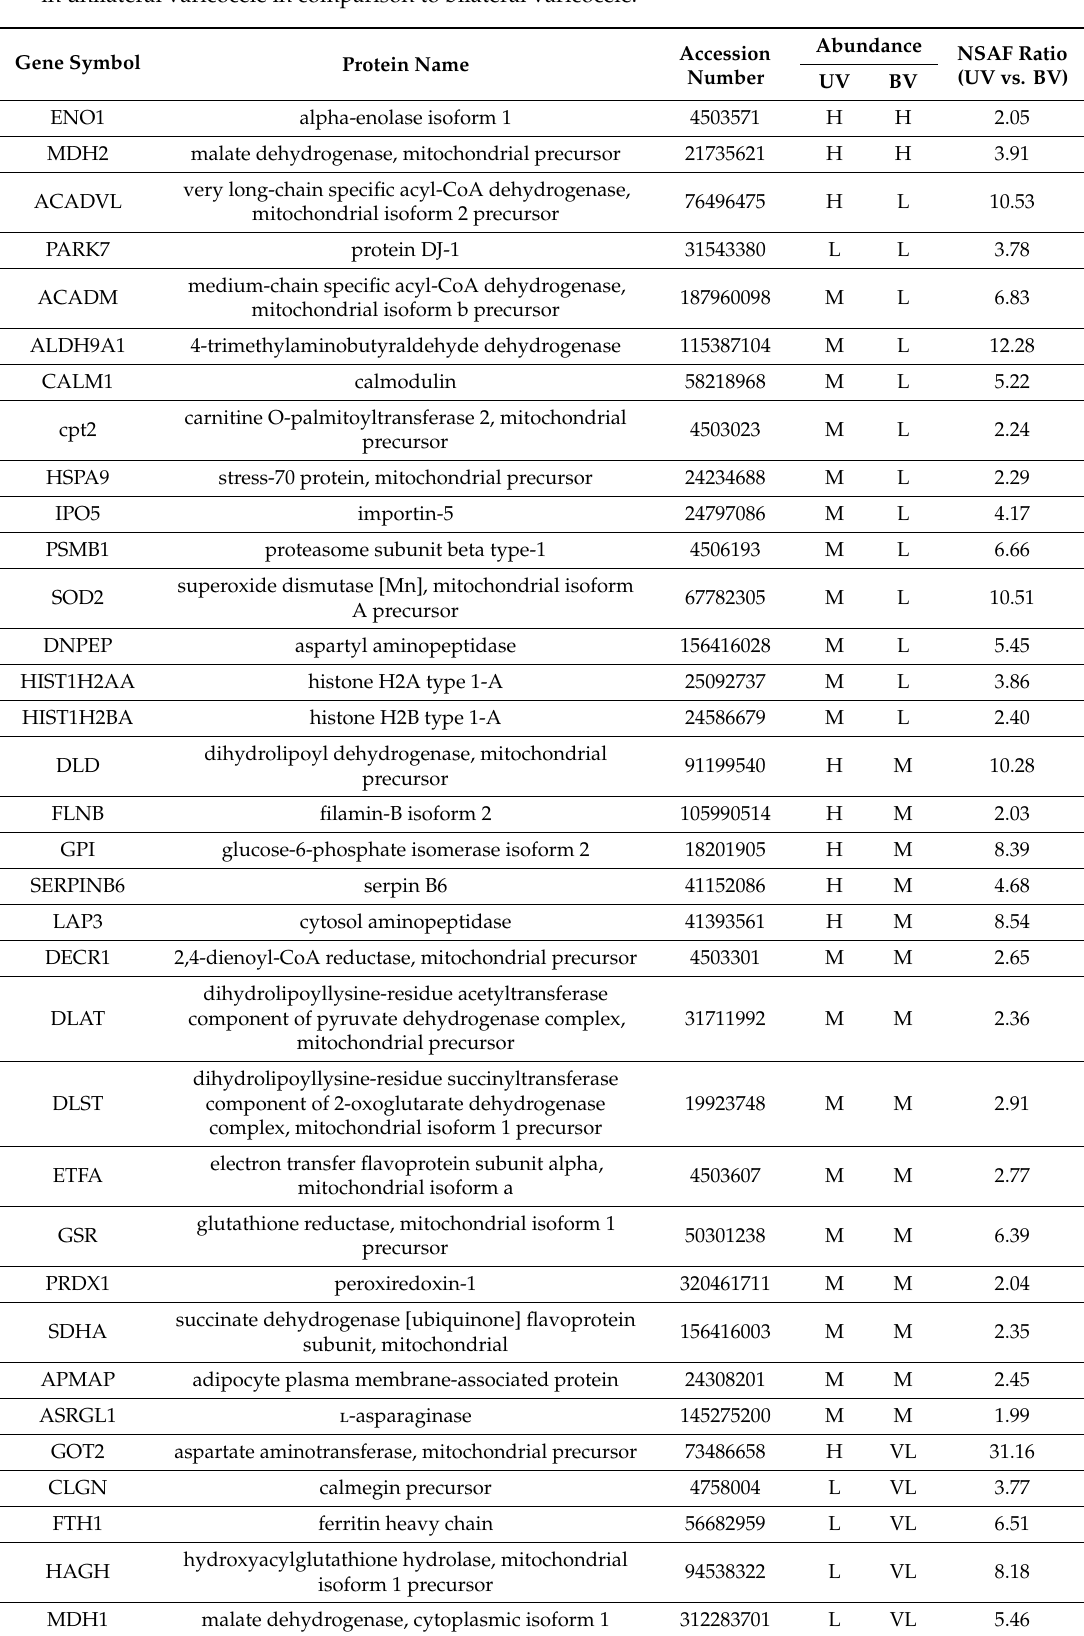
Table 2. Comparison of the enrichment of lysine-acetylated functional sperm proteins overexpressed in unilateral varicocele in comparison to bilateral